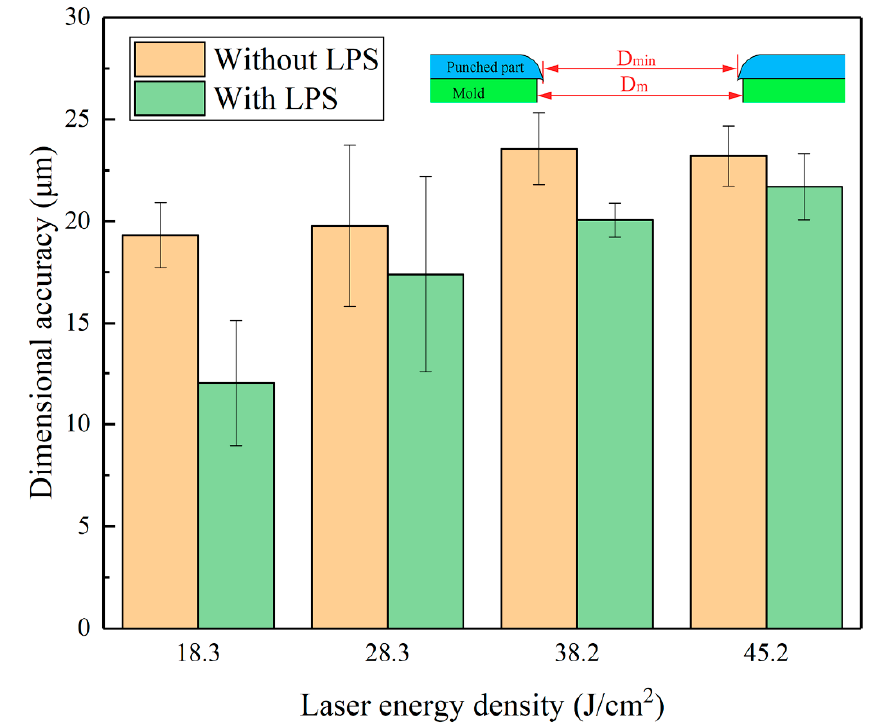
Figure 14. Influence of the laser energy density on the dimensional accuracy of punched holes with LPS and without LPS.